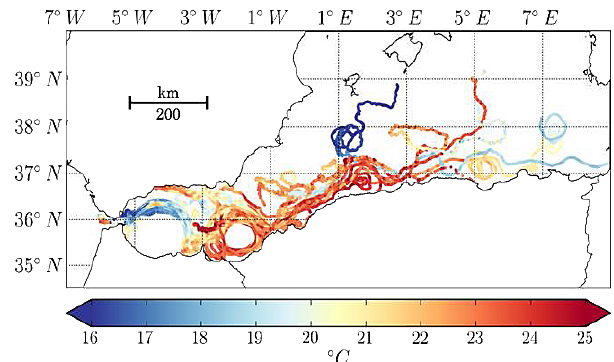
Figure 5. SST values measured along track from the MEDESS- GIB-SG Buoys. Evolution of the buoys until 12/9/2014 ( + 91days after